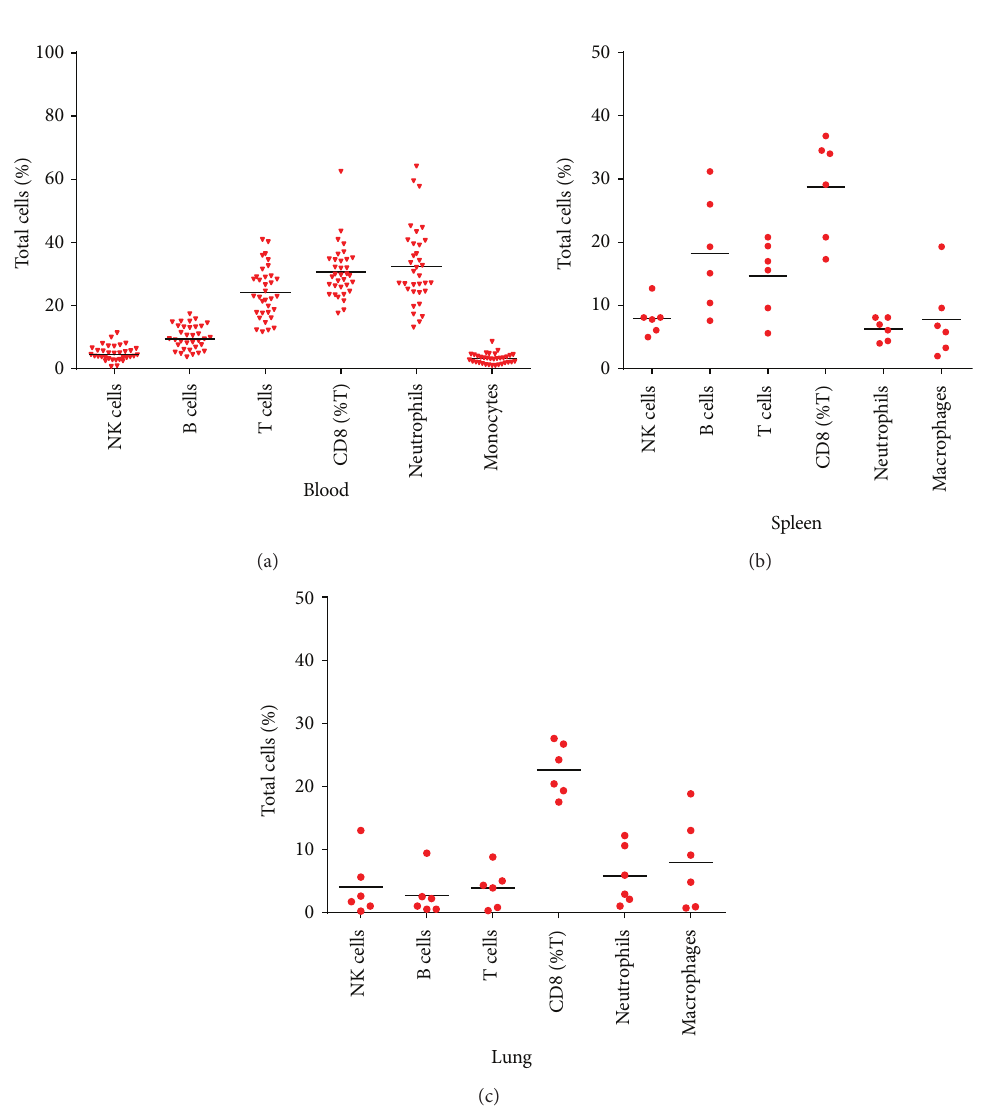
differences are observed in the proportion of both B cells and neutrophils [31], although these differences are highly strain specific. C57BL/6J mice are reported to have 67% B cells and BALB/C mice 46%; both of which are consistently higher than the percentage found in marmosets and humans of approximately 25% (Table 1) [27, 31]. The proportion of neutrophils found in the blood of C57BL/6J mice at 13% is lower than the 35% found in marmosets and the 40– 75% expected for healthy human blood. This is encouraging as neutrophils play a pivotal role in the innate response to infection [36]. A cross-species comparison suggests that monocytes comprise 3% of leukocytes (Table